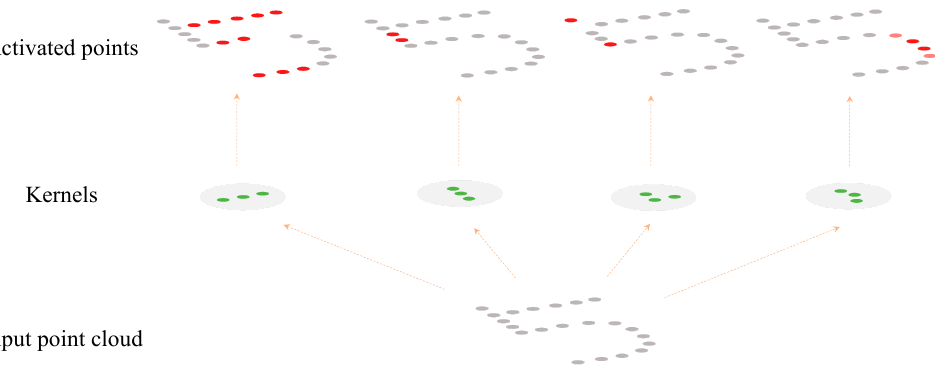
Figure 1. Illustration of kernels and their matching results on the input point cloud. For each point of the input point cloud, we first find its three neighbors and then match them with different kernels. When the local geometric structure is similar to the kernel, the current point is activated correspondingly (darker red means larger activated value).